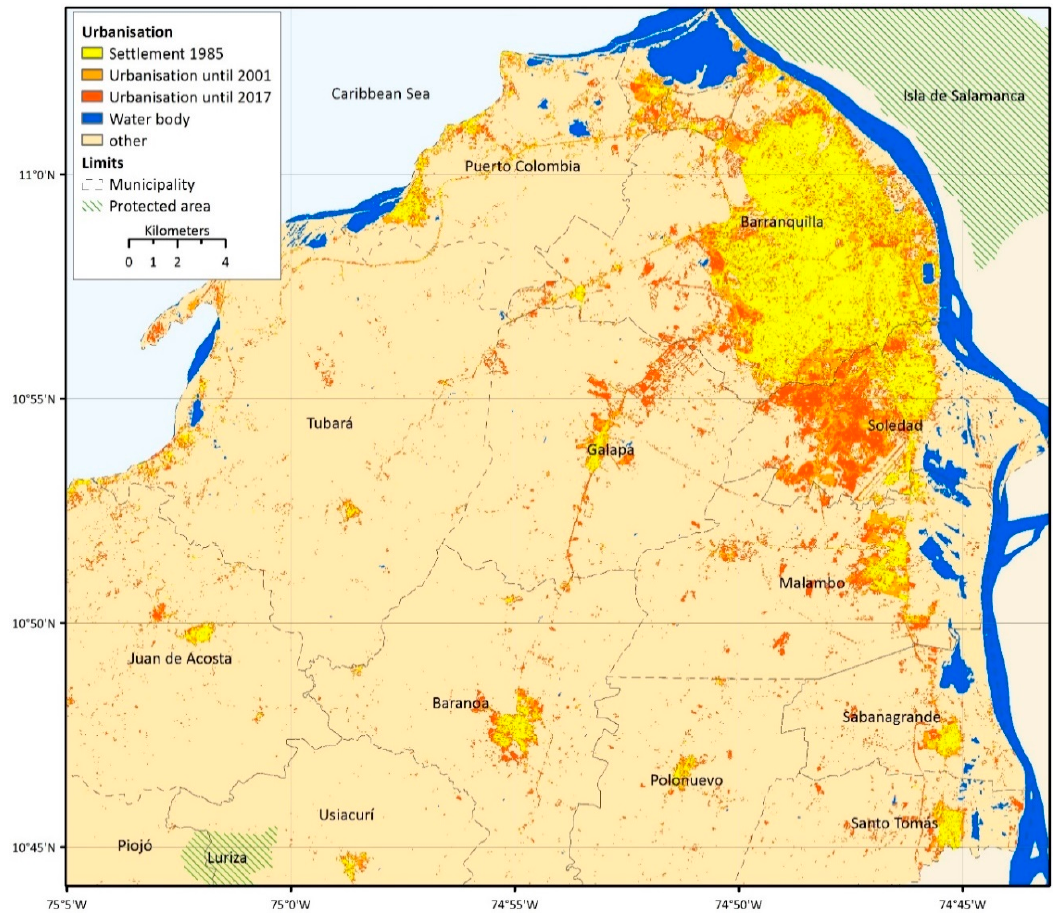
Figure 3. Urbanisation and gain in impervious surfaces in the hinterland of Barranquilla in the years 1985, 2001, and 2017.